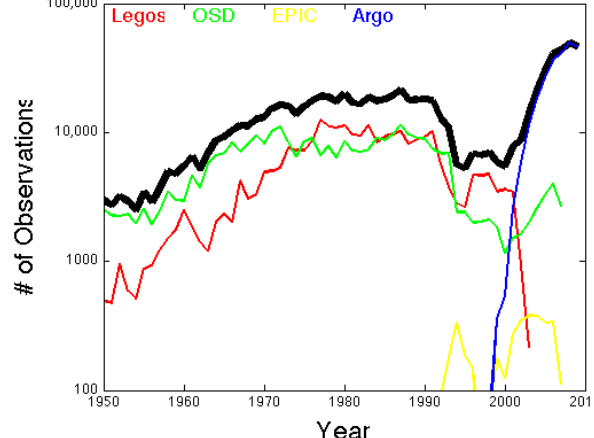
Fig. 2. Time distribution of SSS observations per year in the final dataset. Different colored lines are matched with text at the top of the figure to show which dataset is being plotted. The thick black line is the total for all observations. Note the ordinate is logarithmic. Note also that there was considerable overlap between datasets, par- ticularly Legos and OSD. This figure depicts the final dataset after removal of duplicate